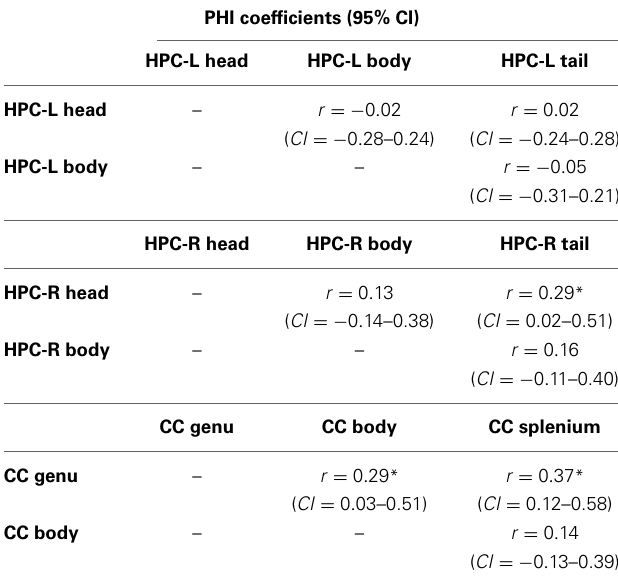
Table 5B | PHI coefficients for sub-structures of the left and right hippocampus and the corpus